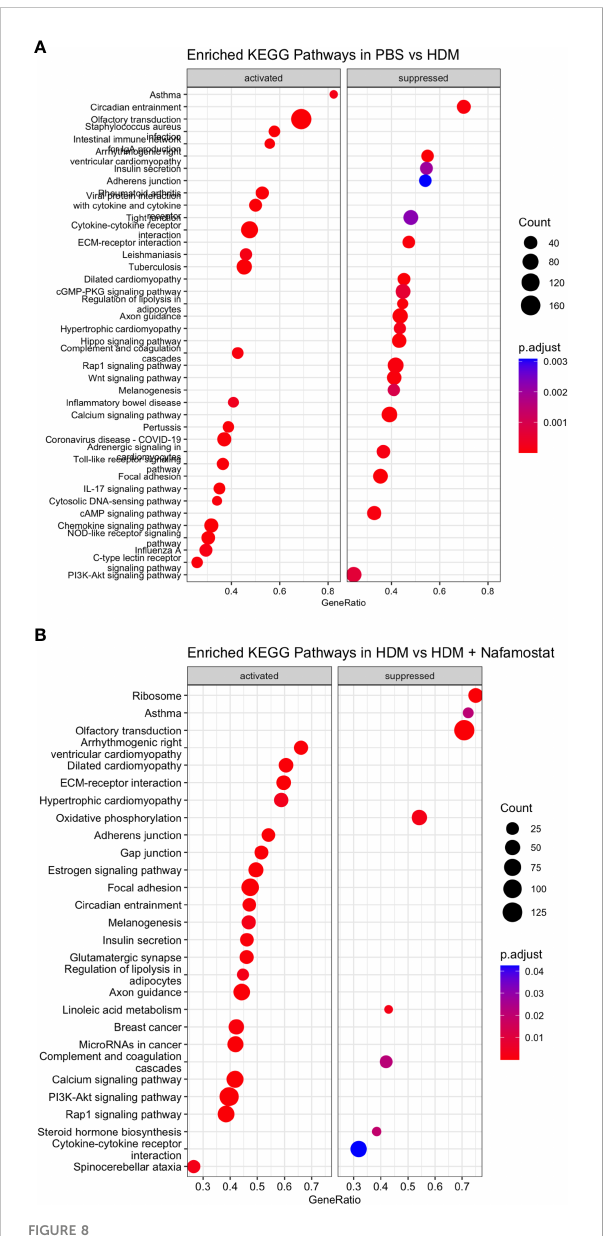
FIGURE 8 Gene set enrichment analysis revealed signi fi cantly enriched top 20 KEGG activated pathways (positive enrichment score) and supressed pathways (negative enrichment score) when comparing the control- (PBS) vs. HDM (A) and the HDM vs. HDM + nafamostat (20 mg/kg) (B) groups. The output of the analyses was visualized using dot plot function in clusterPro fi ler, with the y-axis representing the enriched KEGG pathway and the x-axis representing the gene ratio. The enrichment analysis was considered signi fi cant if p adjust ≤ 0.05. n = 3 – 4 mice per group. HDM, house dust